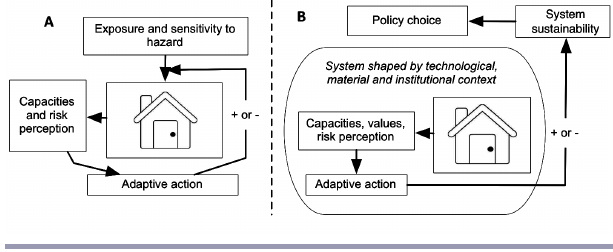
Fig. 2. (A) Traditional framing of influences of adaptive capacity on adaptive action. Those with capacity and/or perception of risk take adaptive action. The action reduces vulnerability to the select hazard. (B) Traditional framing of studies that explore influences on adaptive capacity. The household response to a select policy is viewed as a product of the broader system as well as individual attributes. The implications of adaptive choice (behaviors in response to policy) on system sustainability are